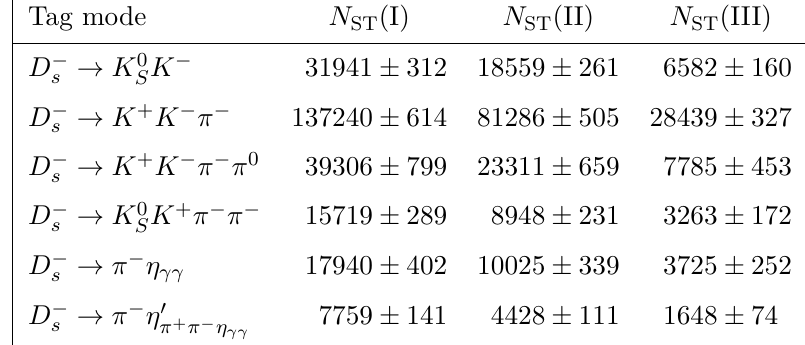
√ s = (I) 4.178 GeV, (II) 4.189–4.219 GeV,